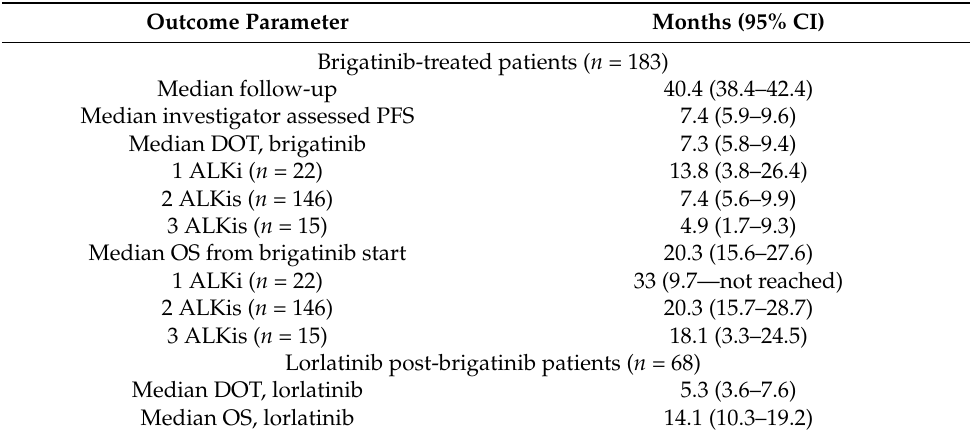
Table 4. Outcome parameters for the 183 brigatinib-treated patients.